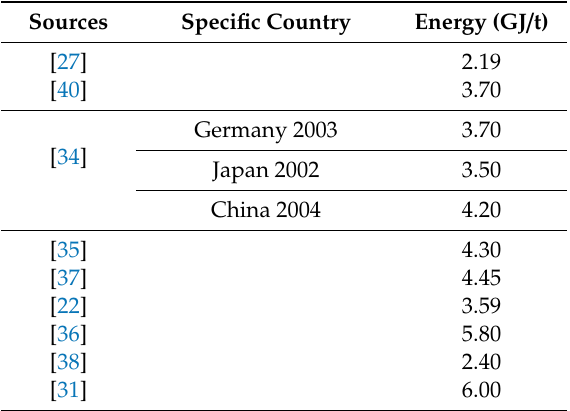
Table 7. Coke manufacturing energy per ton of coke.